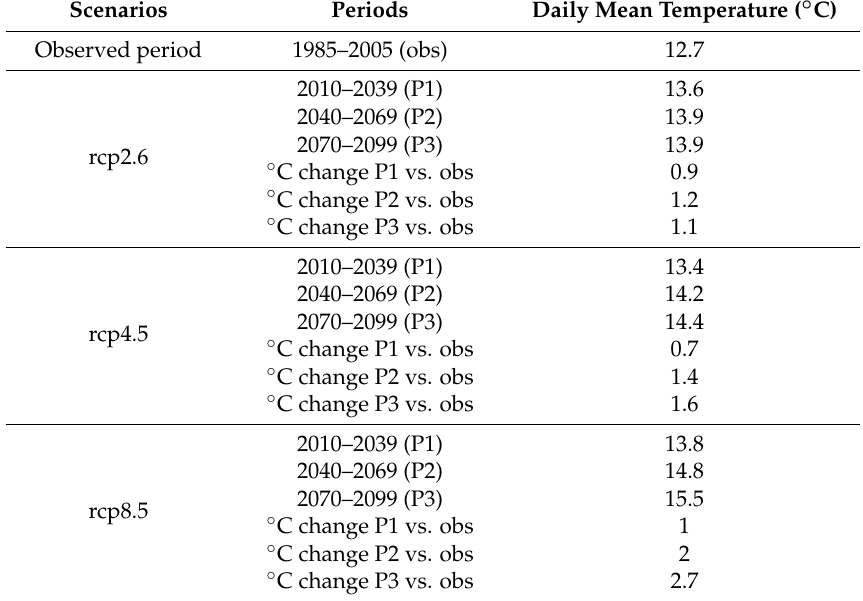
Table 2. Results of the daily mean temperature predictions of the CanESM2 scenarios for the periods